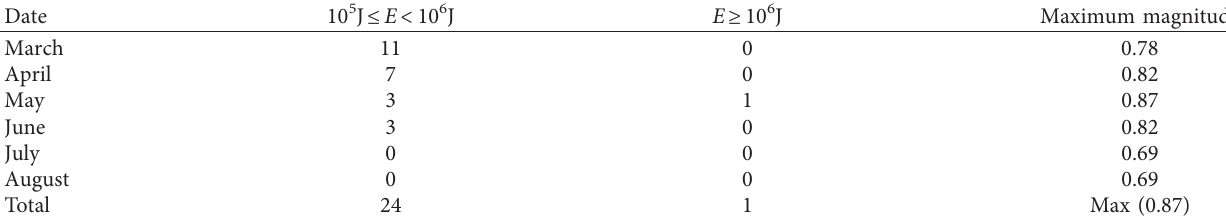
Table 5: High-energy frequency